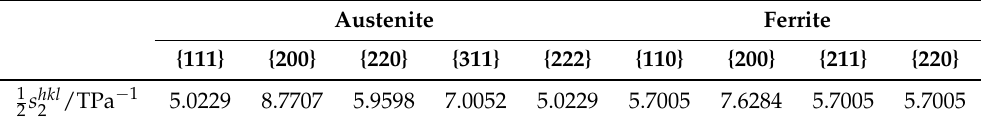
s hkl Table 3. Diffraction elastic constants 1 used for the austenitic phase and the ferritic phase. 2 2 Austenite Ferrite {111} {200} {220} {311} {222} {110} {200} {211} {220} 1 s hkl /TPa − 2 2